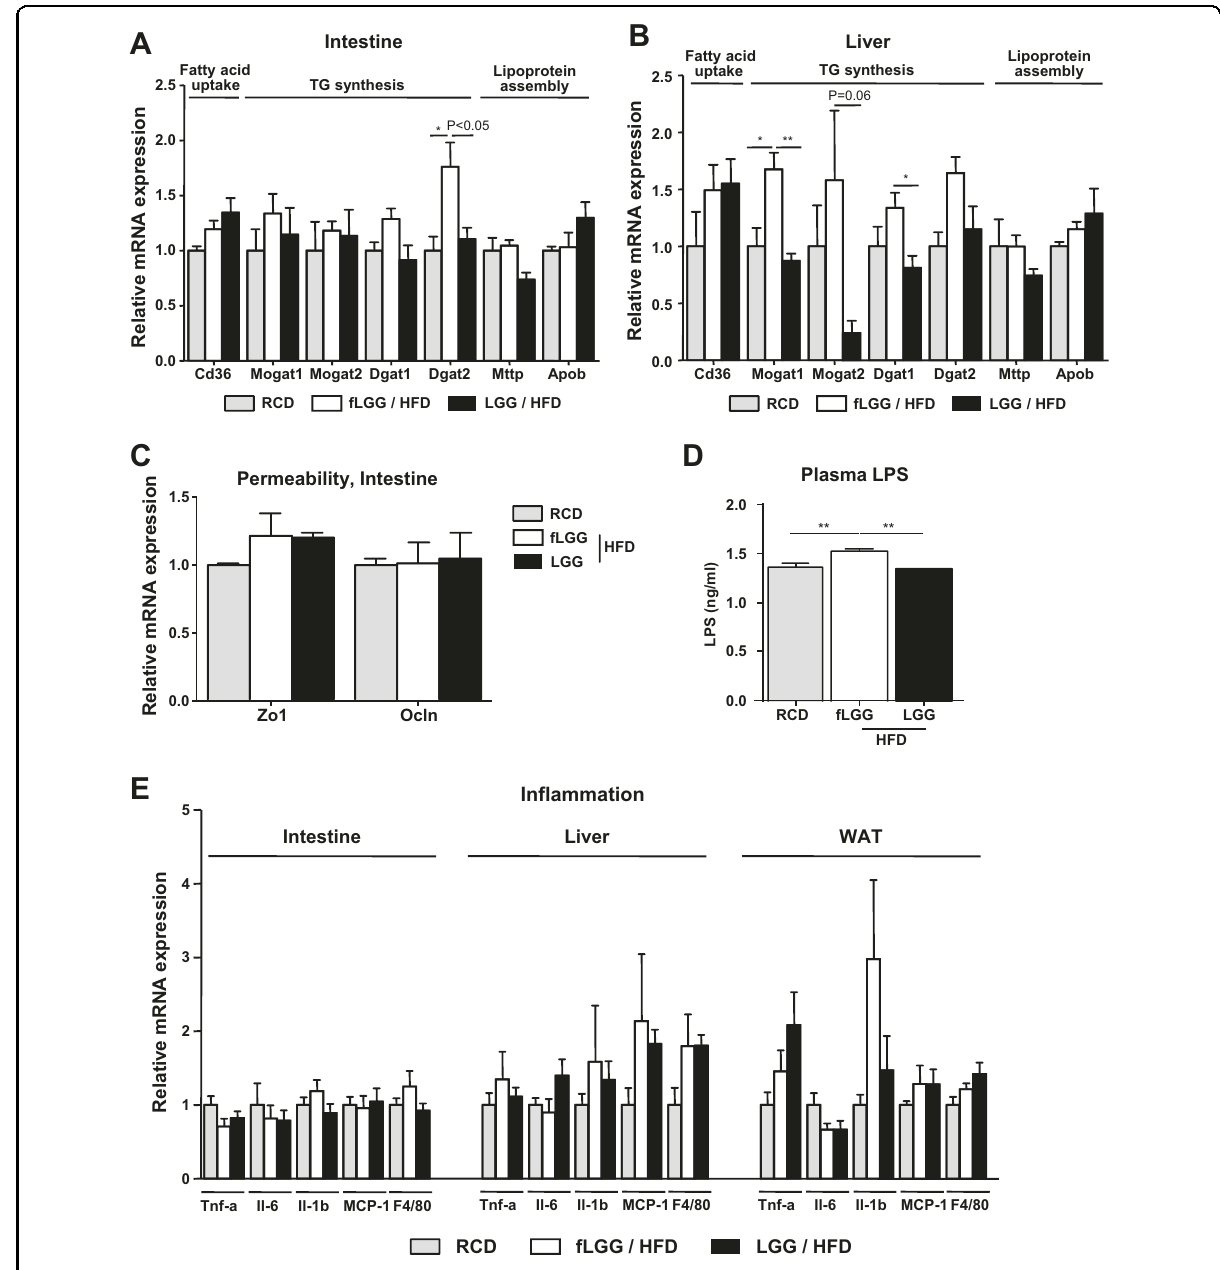
Fig. 5 The effect of L. rhamnosus GG on lipid metabolism, gut permeability, and in fl ammation during short-term HFD feeding. mRNA expression of genes related to fatty acid uptake, TG synthesis and lipoprotein assembly in the a intestine and b liver. c mRNA expression of genes related to gut permeability. d Plasma LPS concentration. e mRNA expression of genes related to in fl ammation in the intestine, liver, and epididymal WAT. Data are expressed as the mean ± SEM ( n = 5 – 6 per group). * P < 0.05 and ** P < 0.01 by one-way ANOVA with post hoc analysis.